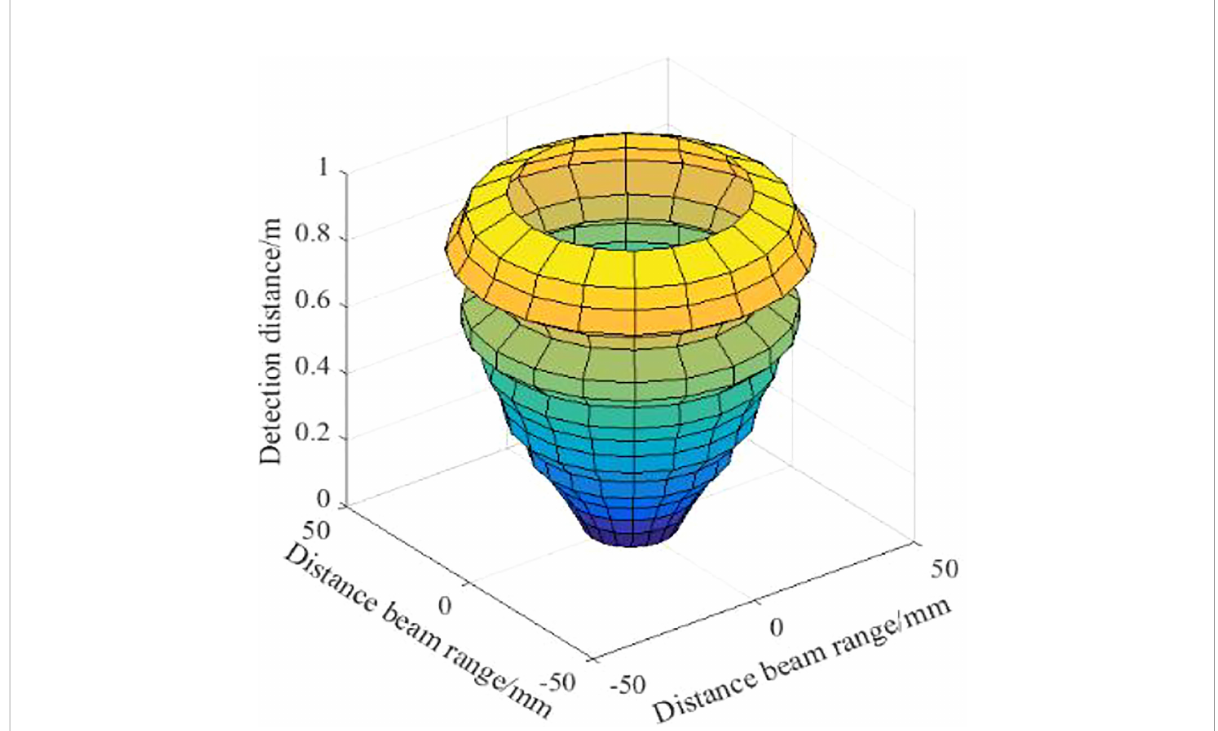
FIGURE 11 Wheat with different canopy density. The range of the acoustic cone of the ultrasonic sensor is “ spindle ” , and the width of the acoustic cone increases linearly with the increase of the detection distance.